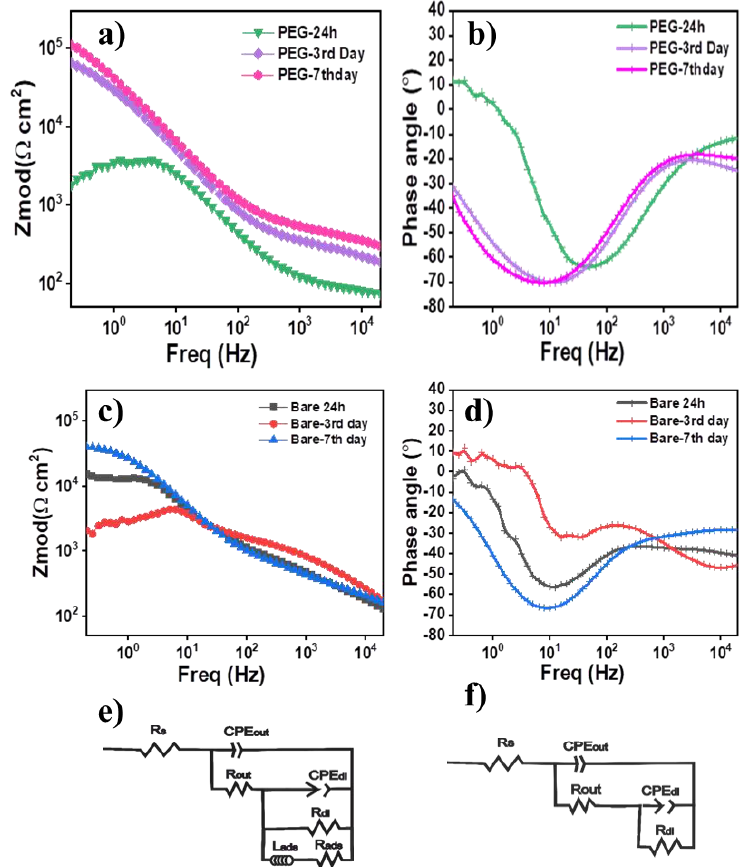
Figure 7. Bode and phase angle plots of ( a ) bare AZ31B alloys and ( b ) 58S PEG coating immersed in Hank’s solution from 24 h to 7 days. Equivalent circuit for ( c ) 24 h and ( d ) for 3 and 7 days for 58S PEG sample.